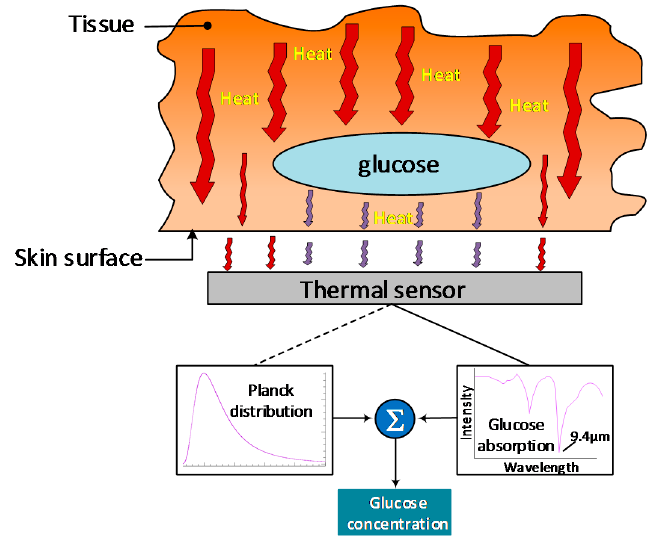
Figure 11. Thermal emission spectroscopy principle.